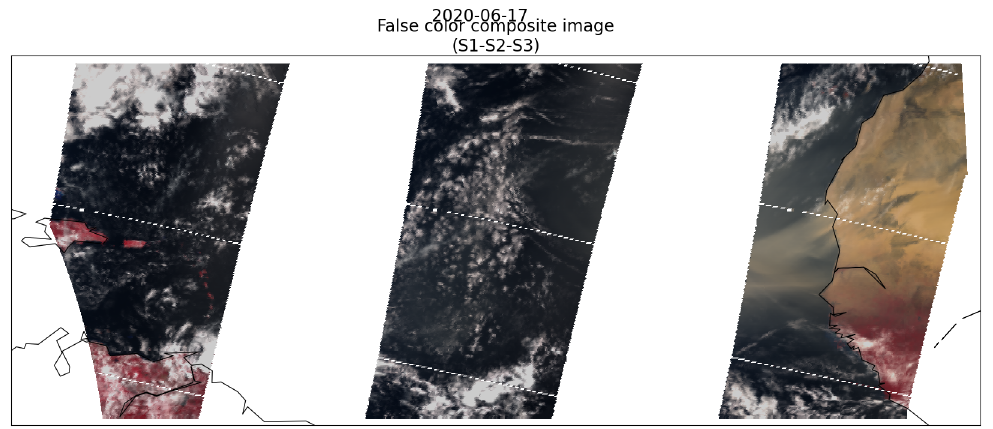
Figure 8. False-color composite obtained from SLSTR bands S1, S2, and S3 over the Atlantic Ocean during 17 June 2020. A thick dust plume is visible at the western coast of